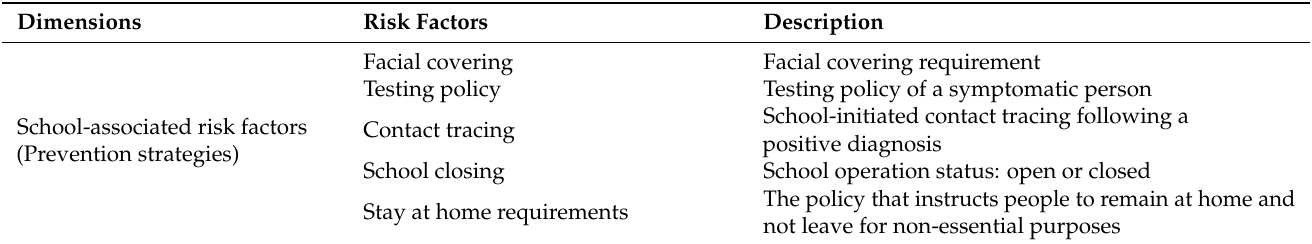
Table 1. Data dictionary for risk factors of COVID-19 transmission within educational